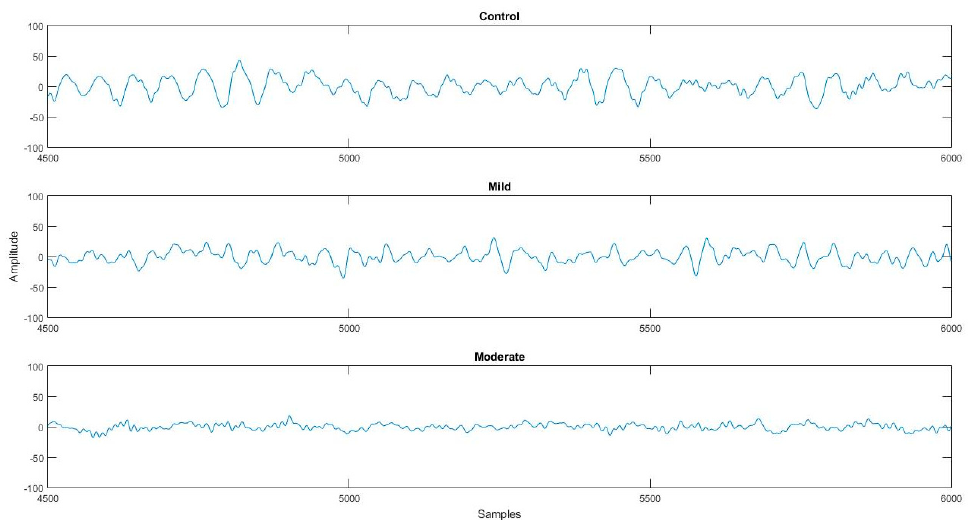
Figure 1. A segment of 3 s extracted from a 12-s epoch of O1 of three di ff erent subjects (control, mild Alzheimer’s Disease (AD) patient, and moderate AD patient).